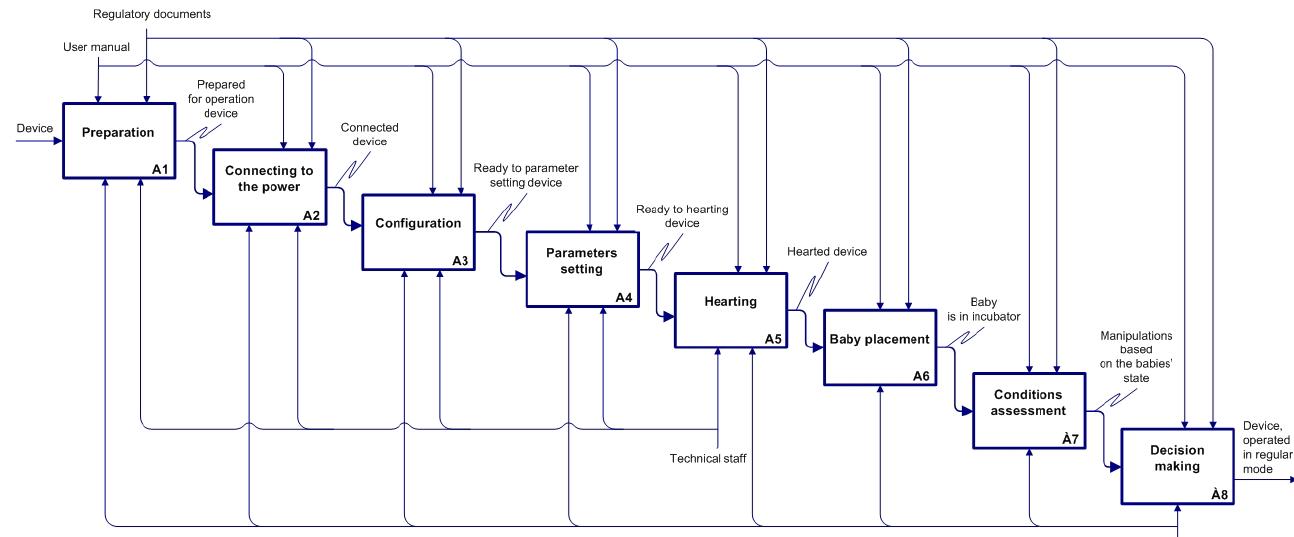
Figure 4. Functional diagram for the device’s operation (first decomposition